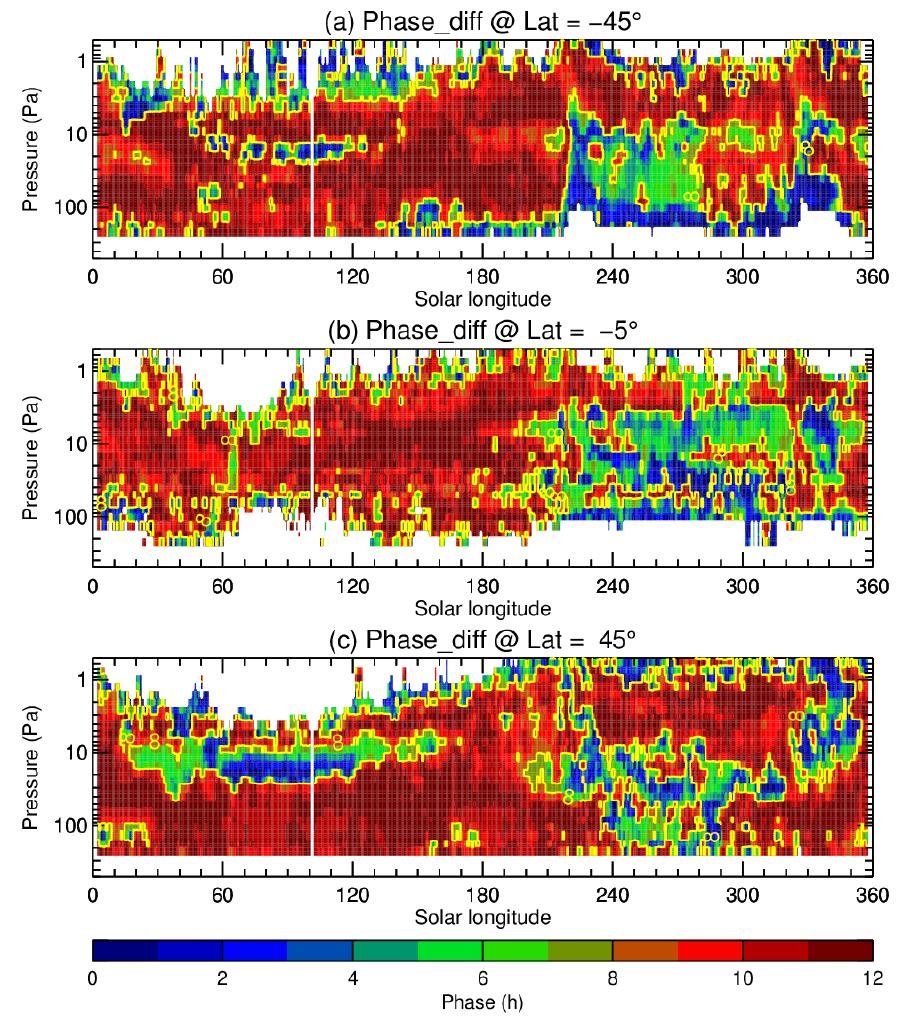
Figure 10. Seasonal variations of the absolute phase differences between the temperature and water ice DW1 at ( a ) 45°S, ( b ) 5°S, and ( c ) 45°N. The gold contours indicate a phase difference of 8 h.